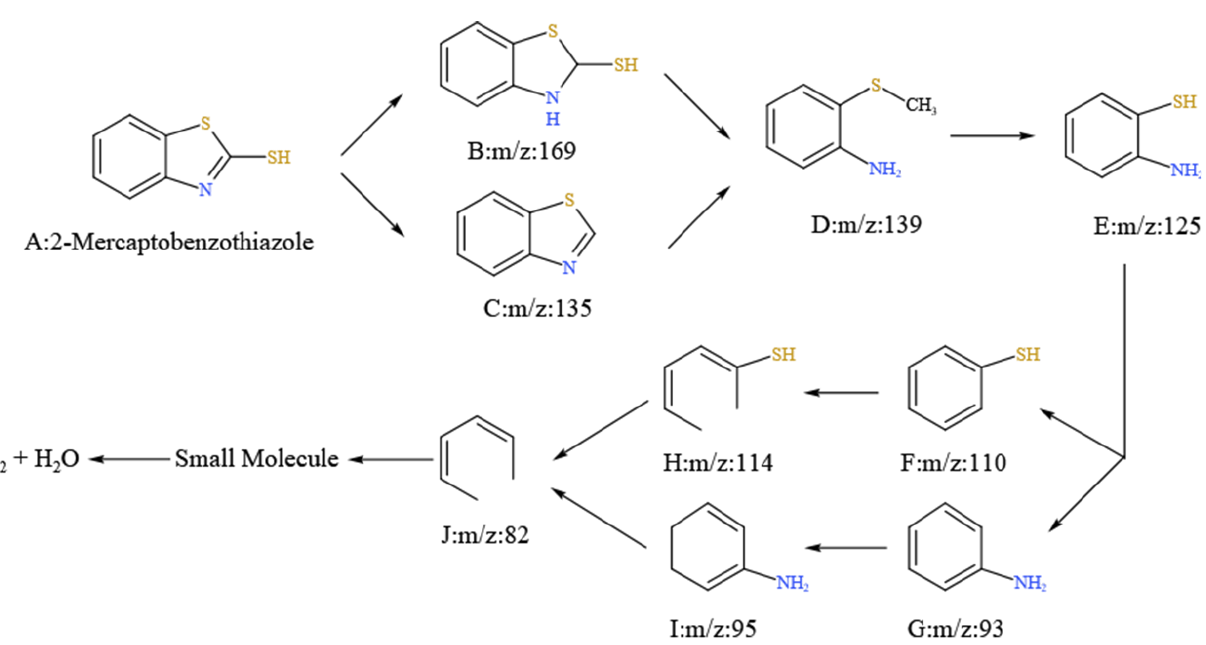
Figure 11. Possible transformation pathways of MBT degradation.